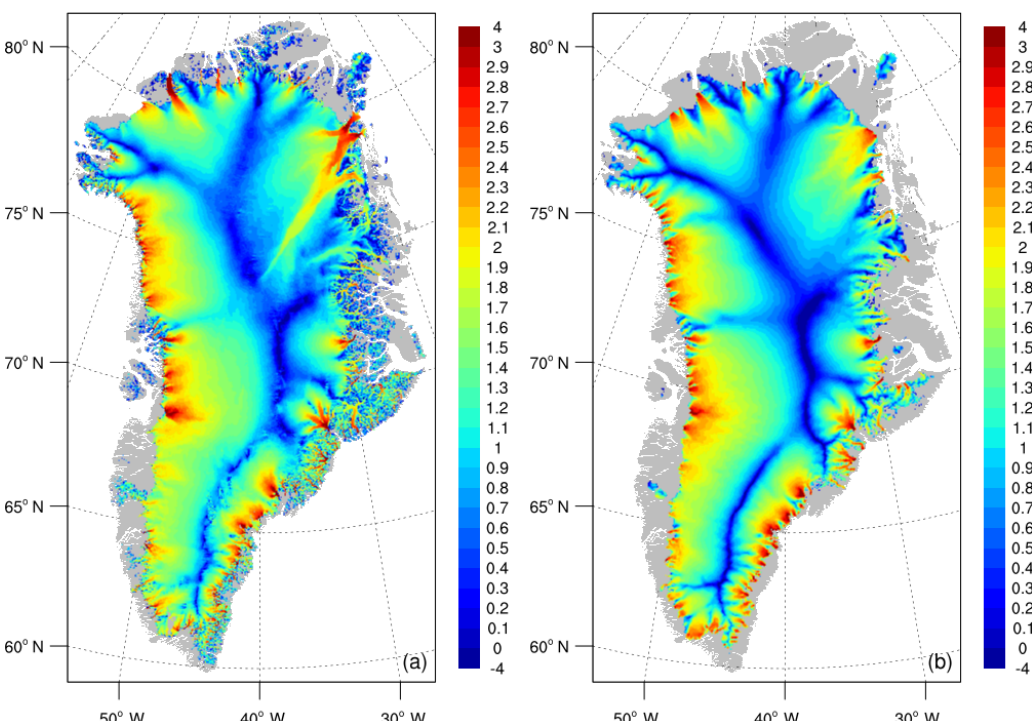
Figure 10. Surface ice speed (myr − 1 , log scale) for the Greenland ice sheet. (a) Observed speed (Joughin et al., 2010). (b) Simulated speed at the end of a 50kyr Greenland spin-up without floating ice shelves. The gray background shows ice-free regions. Figures 10–17 were created using the NCAR Command Language